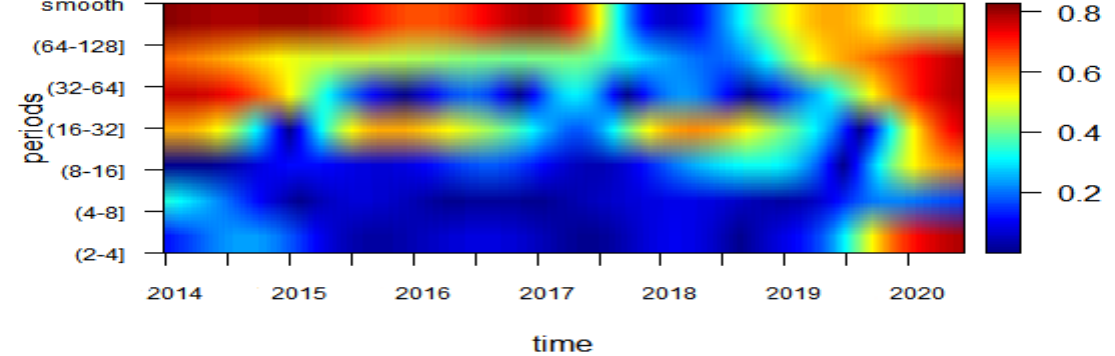
Figure 1. Wavelet multiple correlations between the S&P 500 and FT100 stock market returns.